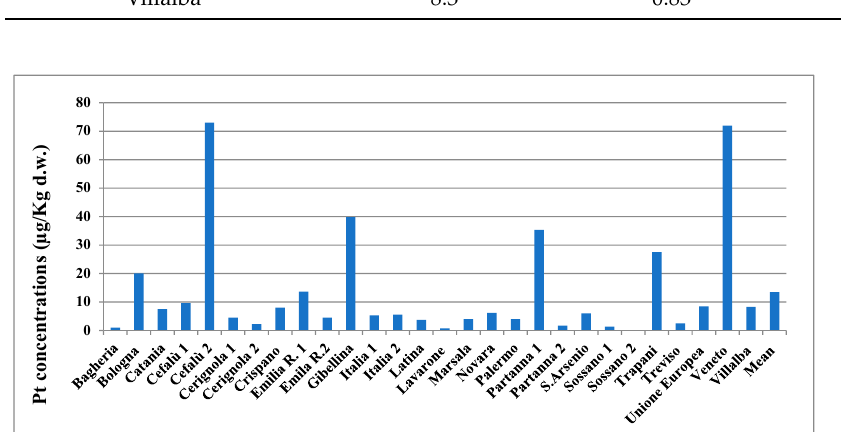
Figure 2 . Platinum concentrations (µg Kg − 1 ) d.w measured on mushroom samples . Figure 2. Platinum concentrations ( µ g kg − 1 ) d.w measured on mushroom